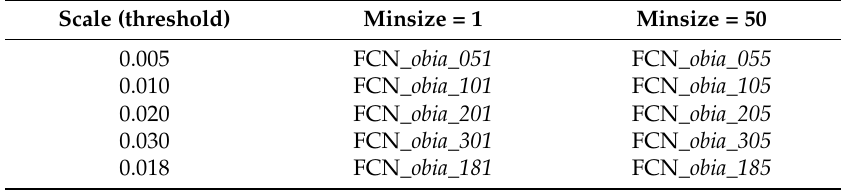
Table 1. A presentation of the segmentation parameters used for refining the FCN classification and the assigned